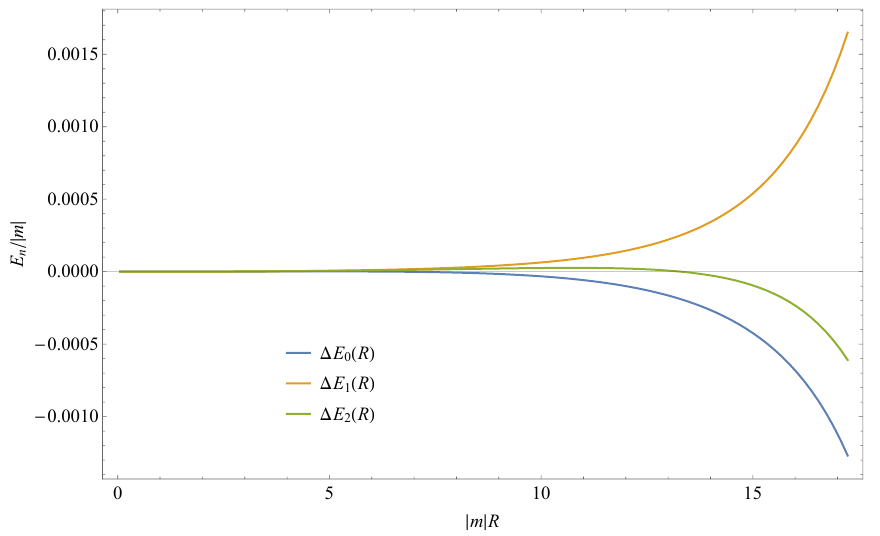
Figure 5 . Comparison of truncation effects for different energy levels, the plots show the deviations ∆ E n ( R ) = E ( L =13) n ( R ) − E ( L =12) n ( R ) , of data at different truncation levels. Unfortunately, no analytic estimate of errors due to the truncation is presently available. This figure is to give a rough estimate of the accuracy of the TFFSA data E 0 , E 1 , E 2 at L = 13 only. For higher E n the truncation errors are generally